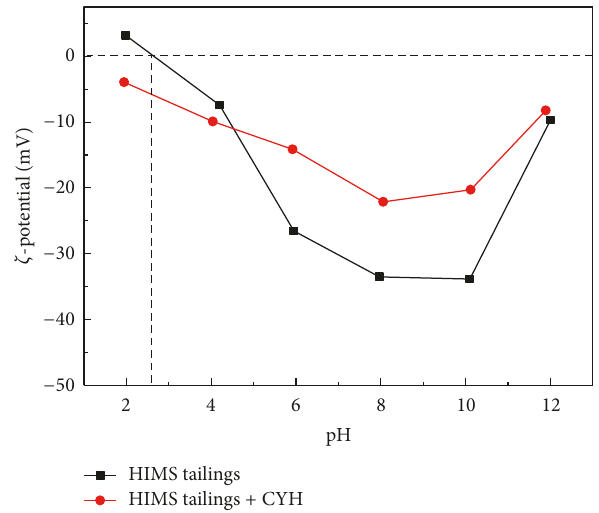
Figure 7: The zeta potential of HIMS tailings as a function of pH in the absence and presence of